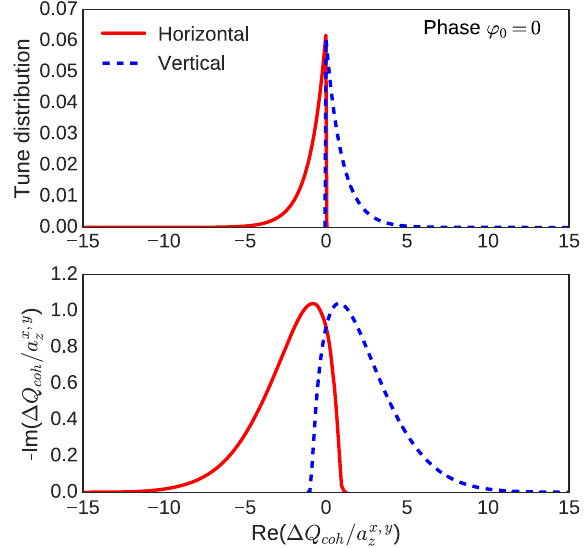
FIG. 6. Top: Incoherent tune distributions obtained analytically for a Gaussian beam with a single rf quadrupole with a phase of φ 0 assuming β β 0 ¼ x ¼ y . Bottom: Corresponding stability diagrams determined by solving Eq. (9) numerically for an azimuthal mode m ¼ 0 head-tail